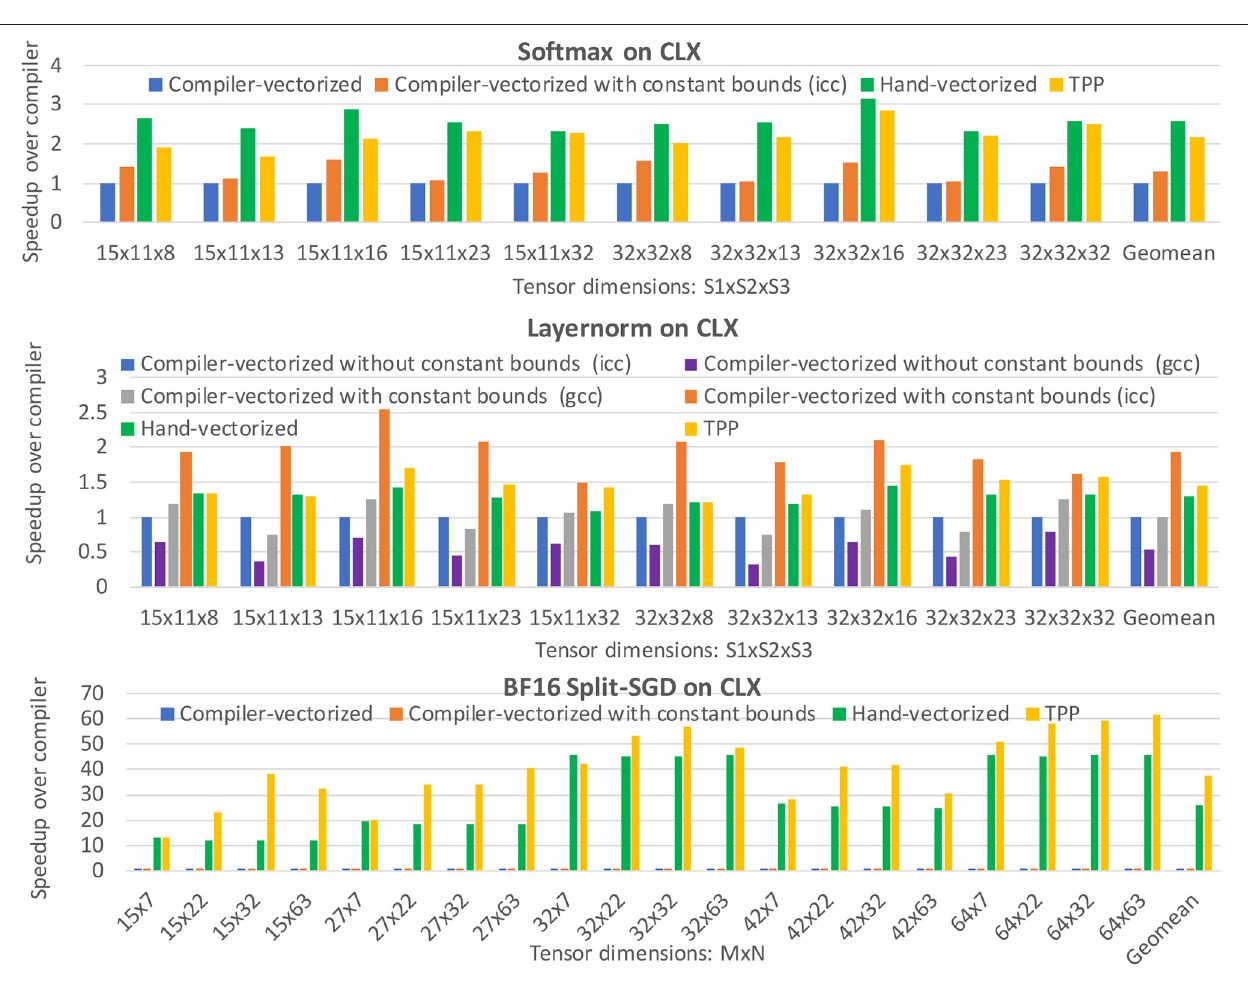
FIGURE 19 | TPP kernels on